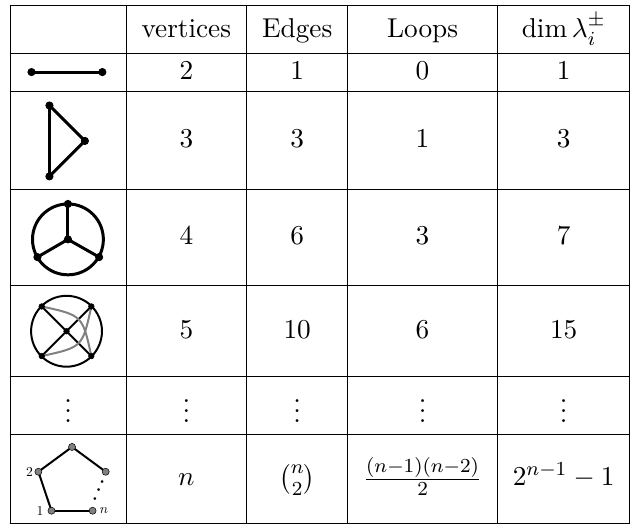
Table 2 . Features of topologies with Maximal number of edges, loops and causal propagators according to the number of vertices. In the topology with n vertices, the grey vertices account for all possible connections among vertices.